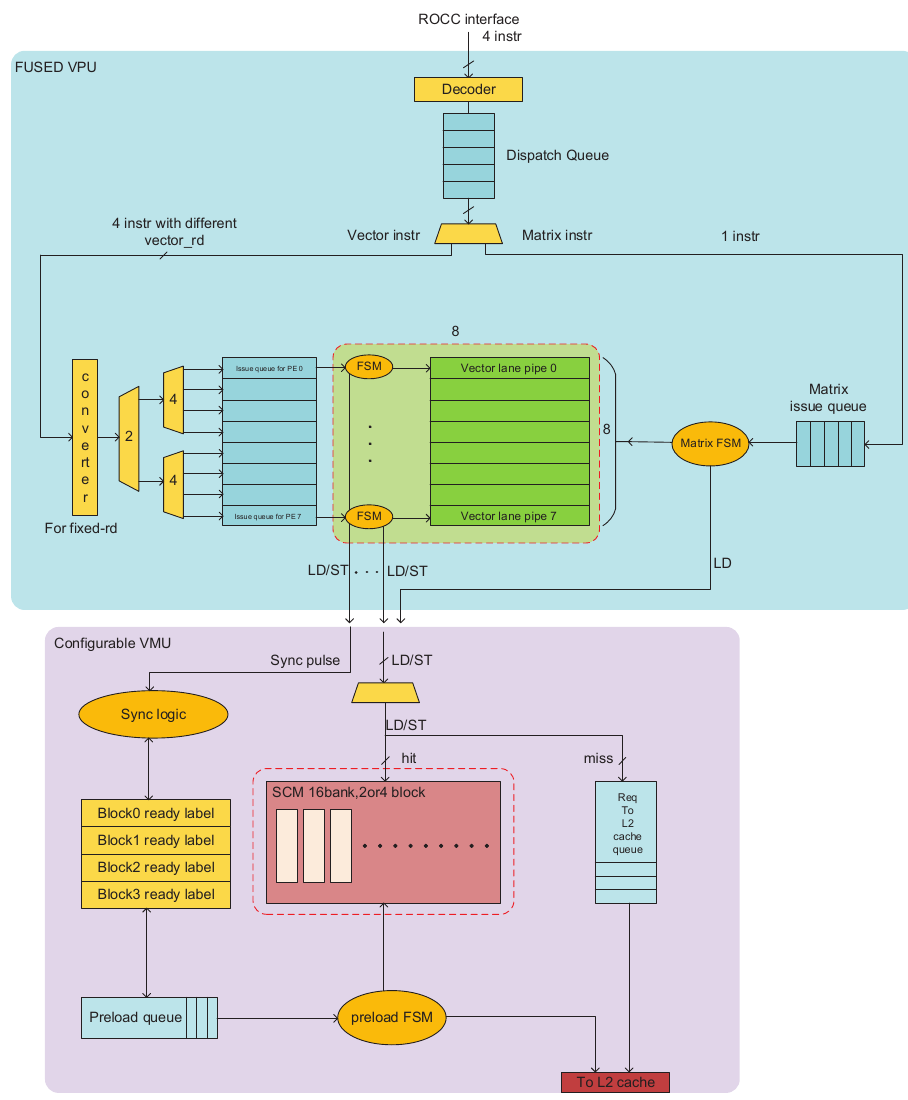
Figure 23. The hardware architecture of